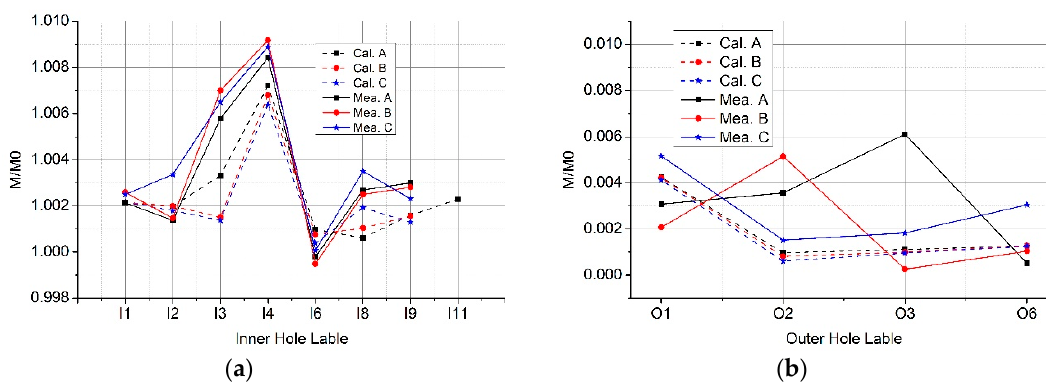
conductors. ( a ) The O-shaped conductor going through the inner holes; ( b ) the O-shaped conductor